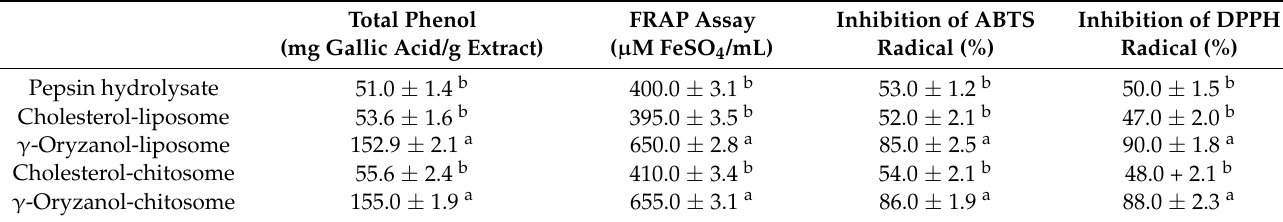
Table 2. Antioxidant activity and total phenol content of hydrolysate-loaded γ -oryzanol-liposomes and